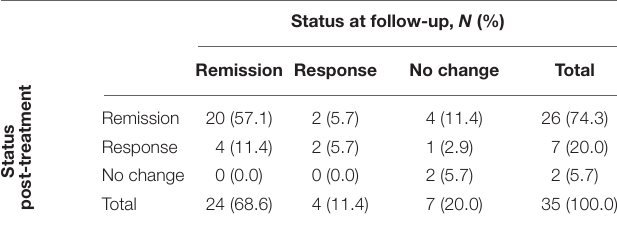
TABLE 3 | Clinical improvement at post-treatment and